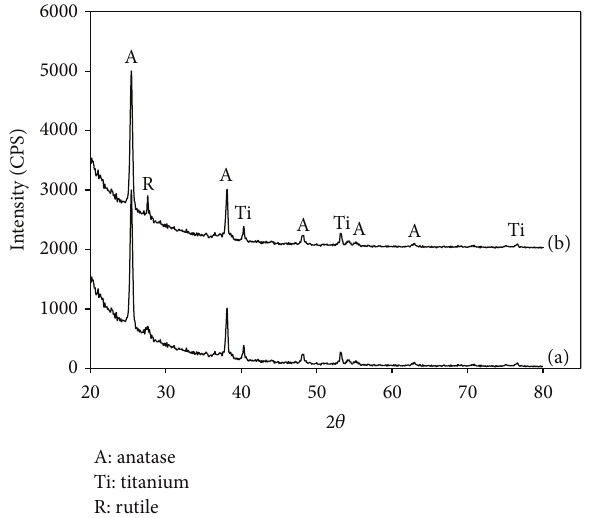
Figure 2: XRD patterns of (a) the unmodified TiO 2 NTs and (b) MIP-TiO 2 NTs.